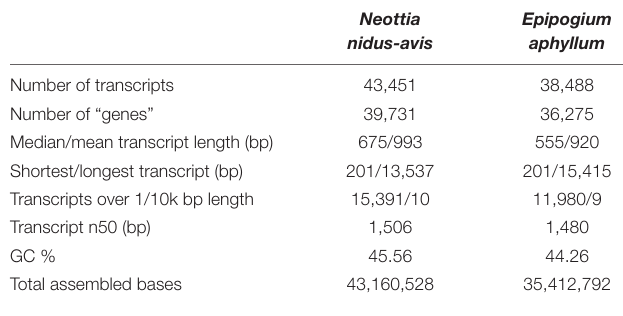
TABLE 1 | Statistics of the final